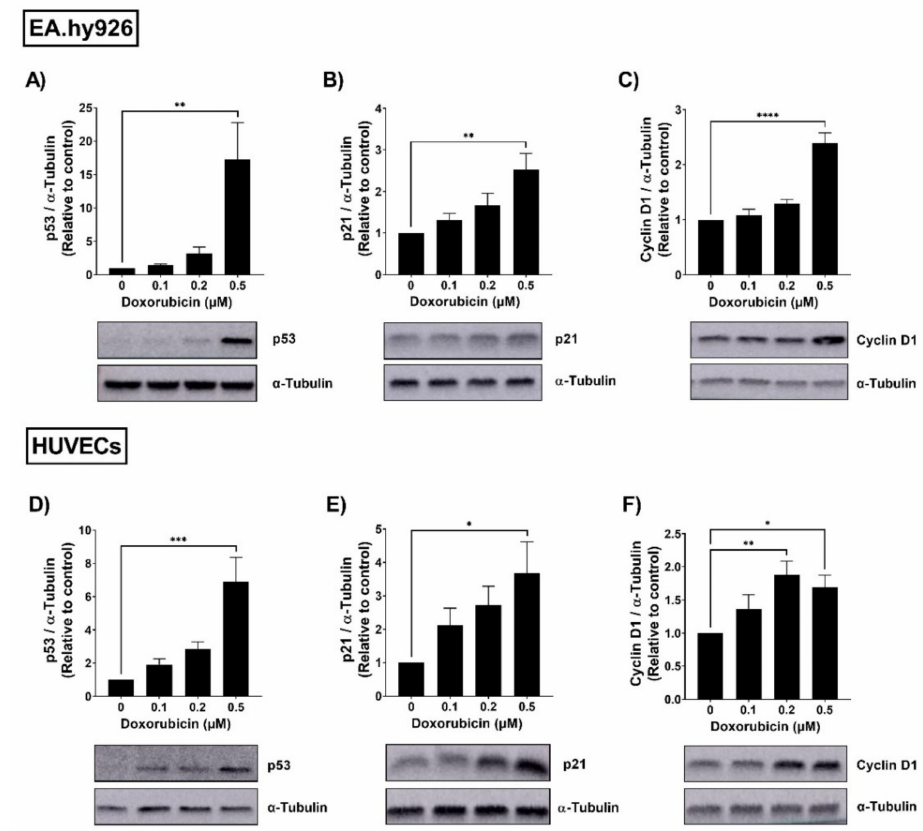
Figure 1. Doxorubicin induces the expression of senescence markers in a concentration-dependent manner in EA.hy926 cells and HUVECs. EA.hy926 human-endothelial-derived cells and HUVECs were treated with increasing concentrations of DOX (0.1 µ M, 0.2 µ M, and 0.5 µ M) for 24 h. Thereafter, DOX was removed and cells were incubated in DOX-free media for 72 h. Then, cells were harvested and the total protein was extracted. Expression levels of senescence markers including p53, p21, and cyclin D1 in EA.hy926 cells (( A – C ), respectively) and HUVECs (( D – F ), respectively) were measured via Western blotting ( n = 4–6). Representative images of Western blots are shown. Values were normalized to α -tubulin and expressed relative to control cells. Values are presented as means ± SEM. Data were analyzed by one-way ANOVA followed by Dunnet’s multiple comparisons test.